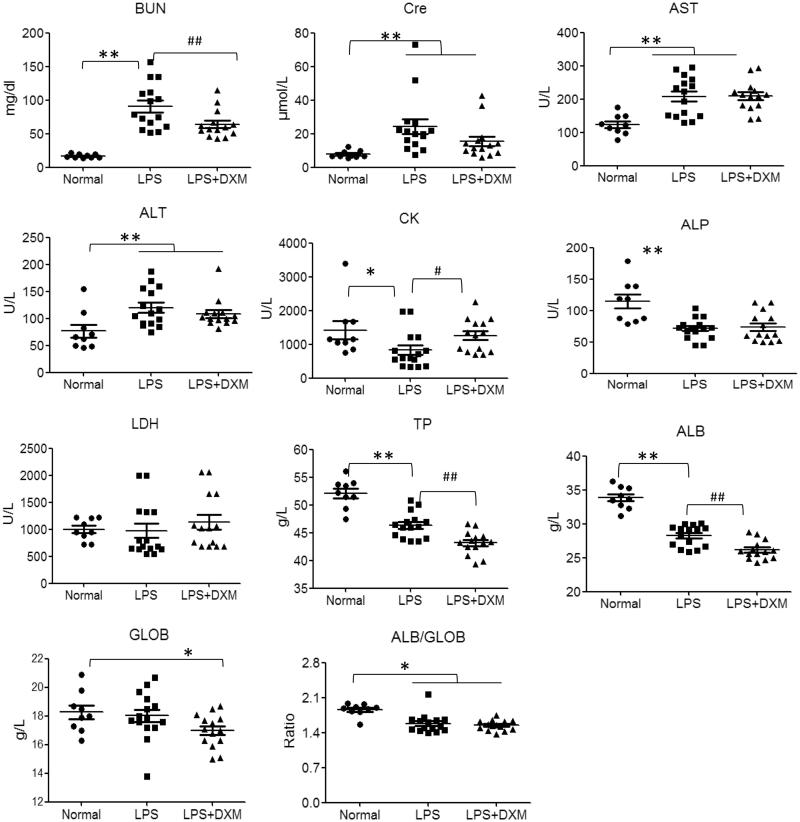
Parameters of biochemistry of serum samples of mice after intravenous administration. Dexamethasone (DXM) was used as 0.5 mg/kg. Data are presented as the mean ± SD (9 mice in the normal group, 15 mice in the LPS group and 14 mice in the LPS + DXM group). *p < 0.05 or **p < 0.01 vs. normal group. #p < 0.05 or ##p < 0.01 vs. LPS group.